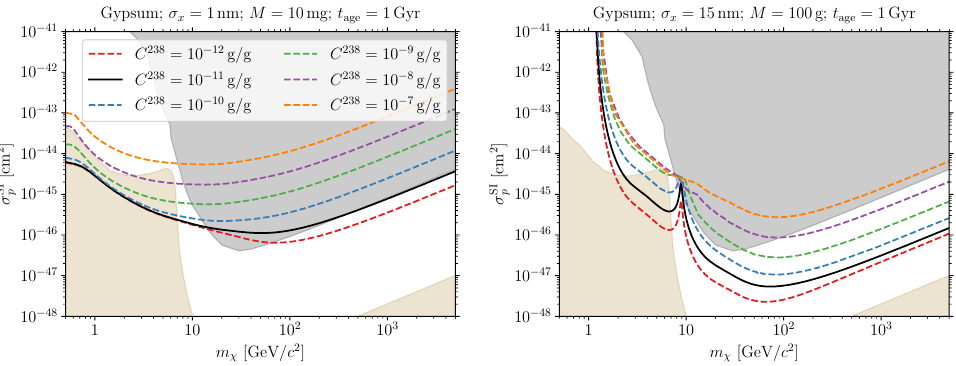
Figure 5. Projected 90% confidence level exclusion limits in a gypsum [Ca(SO 4 ) detector in the high-resolution ( left ) and high-exposure ( right ) readout scenarios for different as- sumptions on the 238 U concentration C 238 controlling the radiogenic backgrounds. The solid black line shows the sensitivity with our fiducial value for marine evaporites, C 238 = 10 − 11 g/g, while the differently colored dashed lines show the projected upper limit for both larger and smaller C 238 . The gray and sand-colored shaded areas indicate current upper limits and the conventional neutrino floor in a Xe-based direct detection experiment, respectively; see Figure 3. Colors and linestyles are the same in both